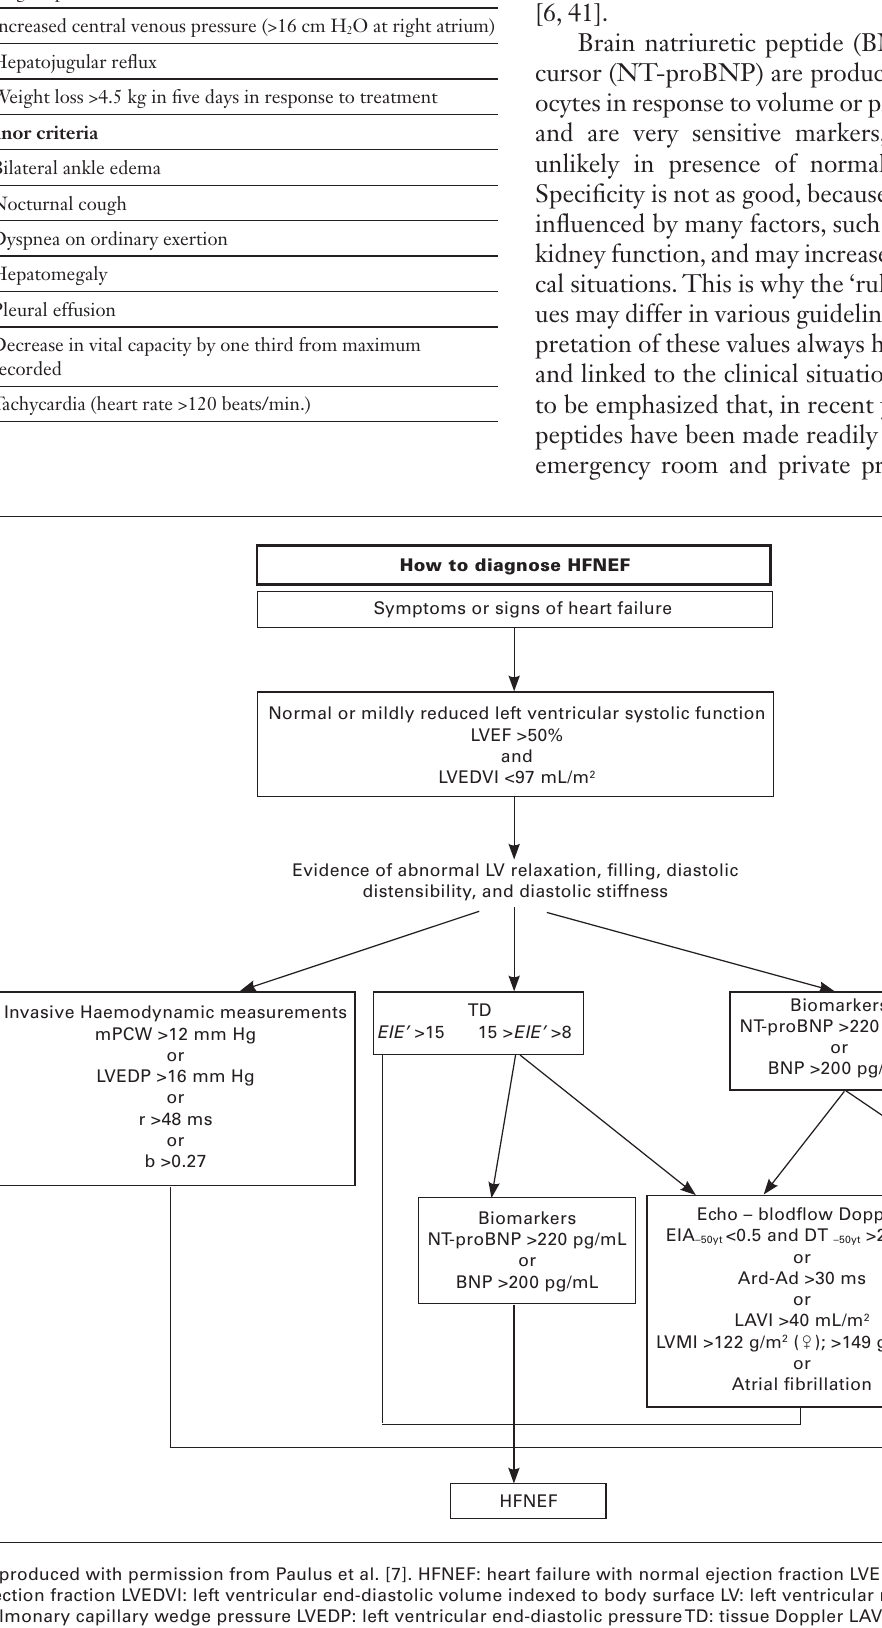
Framingham criteria for the diagnosis of heart failure (HF): HF is diagnosed when 2 major criteria OR 1 major criteria plus 2 minor criteria are present.